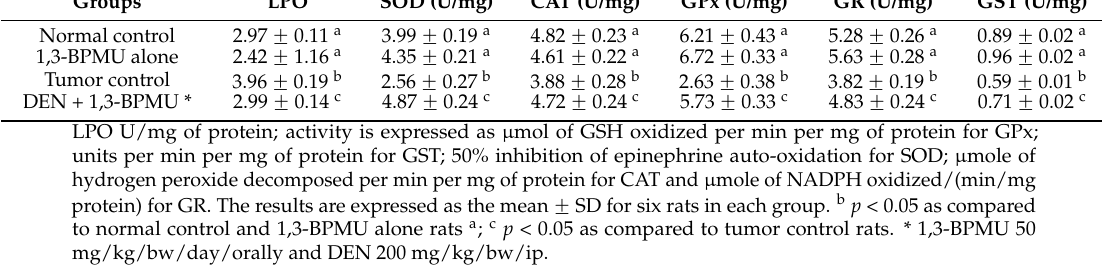
Table 6. Effect of 1,3-BPMU on lipid peroxidation and antioxidant status of control and experimental groups of rats.